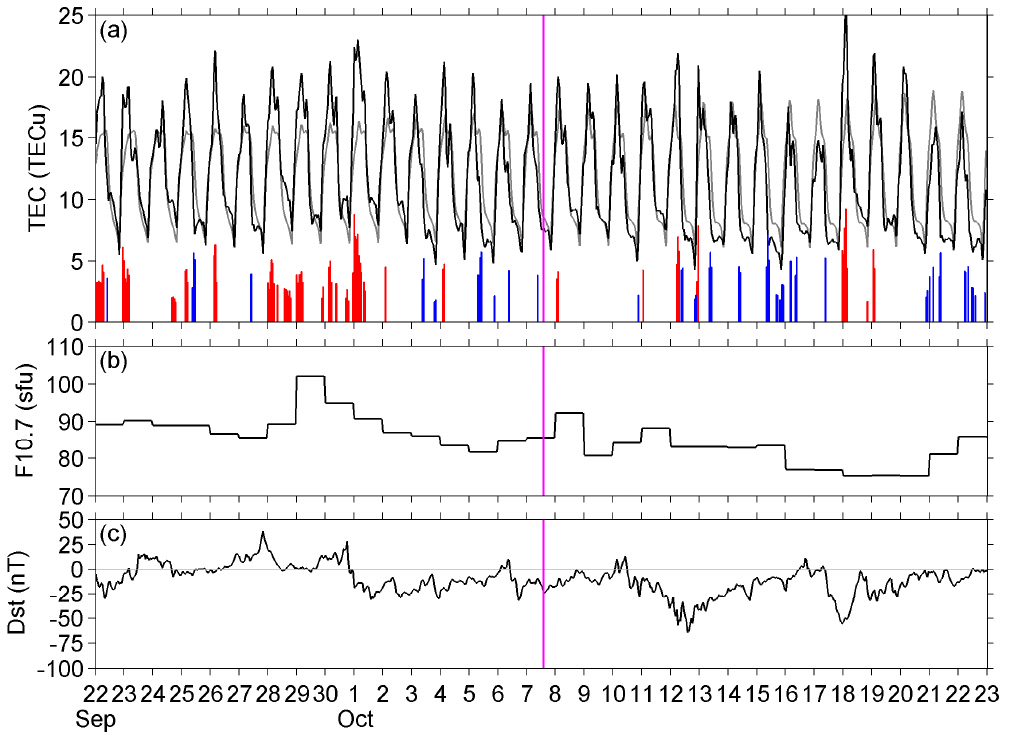
Figure 18. ( a ) TEC, ( b ) Solar radio flux at 10.7 cm (F10.7), and ( c ) Dst index. The red/blue bars in ( a ) refer to positive/negative deviations exceeding ±1.5 σ . A vertical pink line indicates the EQ time.